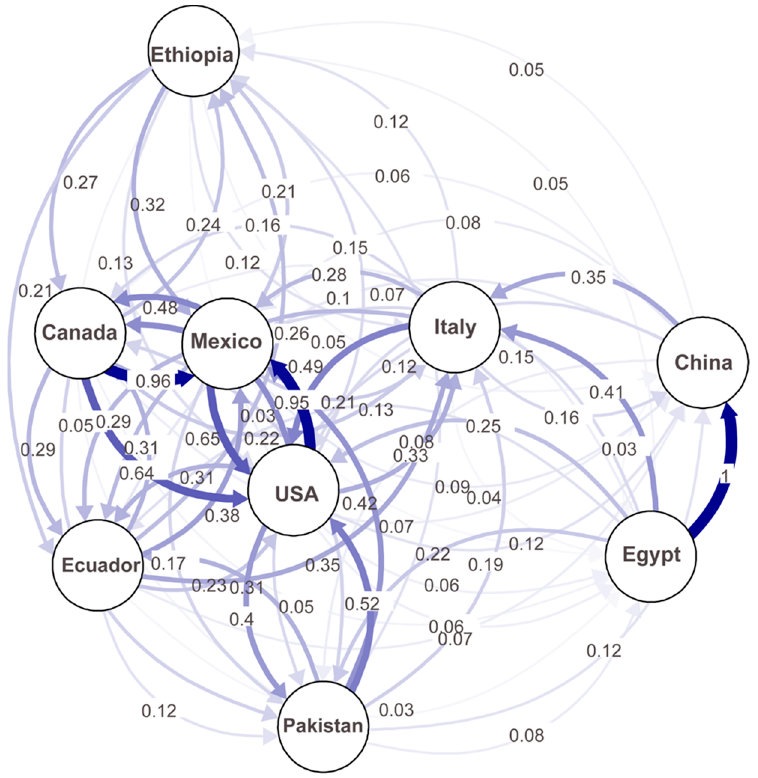
Figure 6. A migration network showing the gene flow patterns among nine country populations of Puccinia striiformis f. sp. tritici . Gene flow strengths are indicated by the line thicknesses.